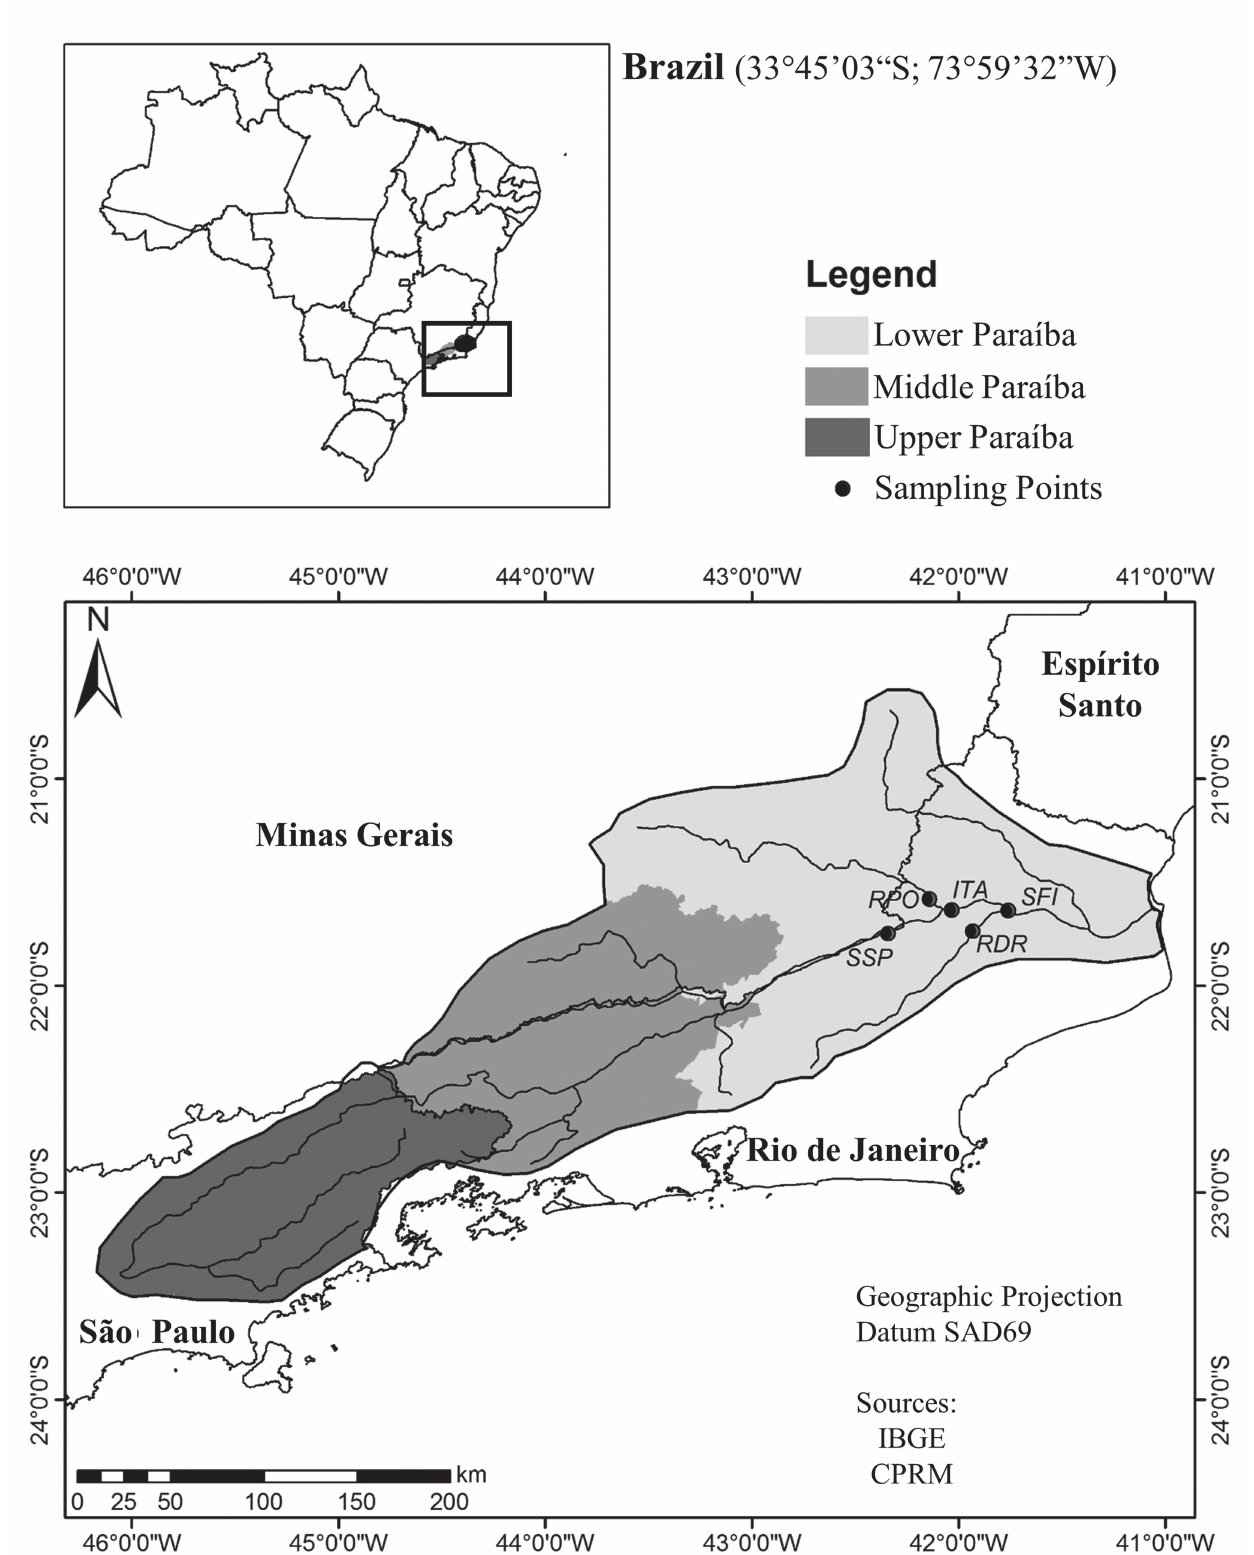
Fig. 1. Lower portion of the rio Paraíba do Sul watershed with the distribution of the five sampling points: rio Paraíba do Sul in Itaocara (ITA), São Sebastião do Paraíba (SSP) and São Fidélis (SFI); rio Pomba in Baltazar (RPO); rio Dois Rios in Guarani